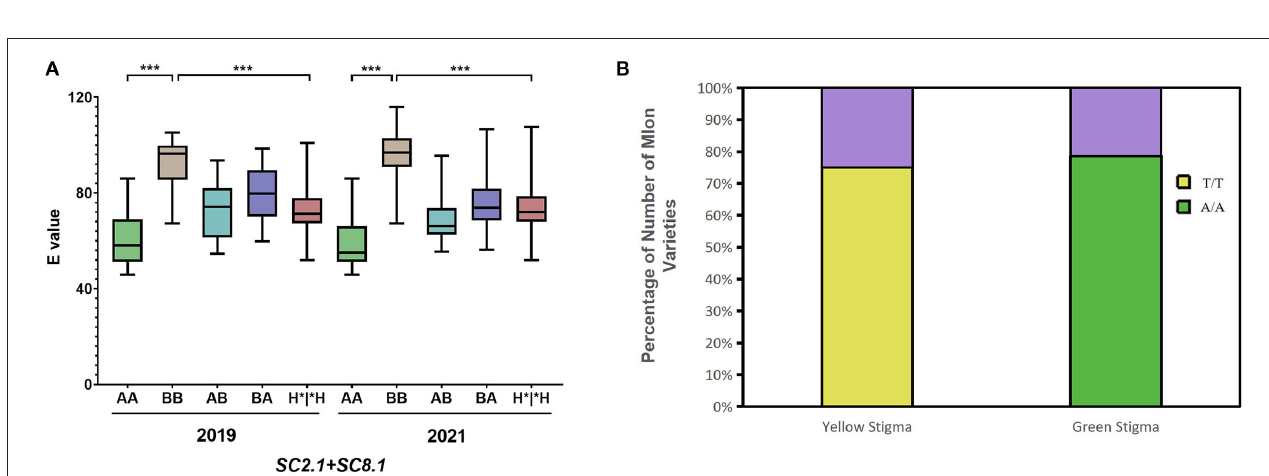
FIGURE 5 | Validation of the stigma color quantitative trait loci (QTLs) in melon. (A) Linkage map of melon chromosome 8 based on 540 F 2 individuals derived from parental lines crossing. (B) QTL curve for melon stigma color.